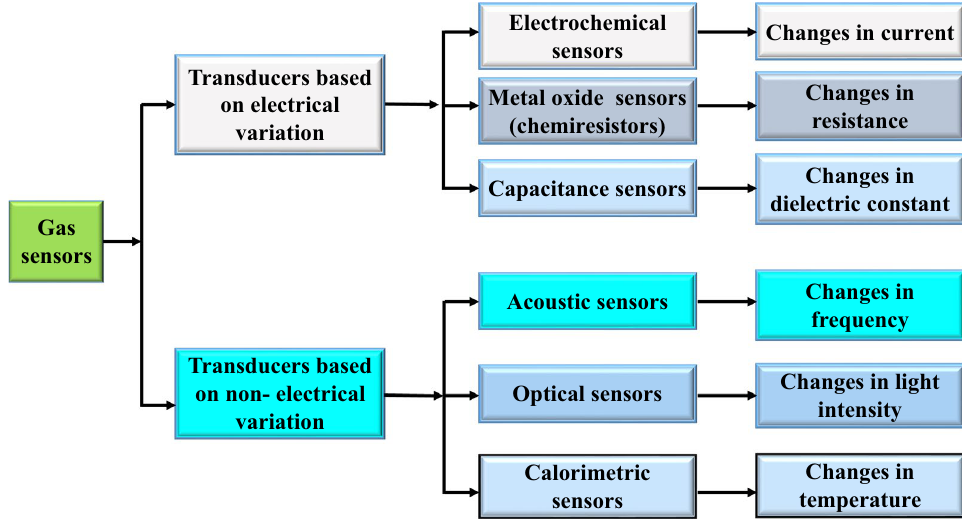
Fig. 2 Classification of gas sensors based on transduction methods